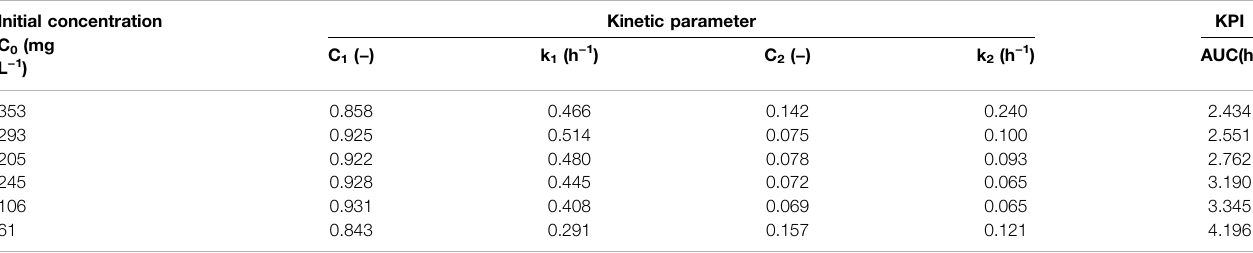
TABLE 1 | Predicted kinetic parameters of bi-exponential models for reactive red 22 dye decolorization a . Initial concentration C 0